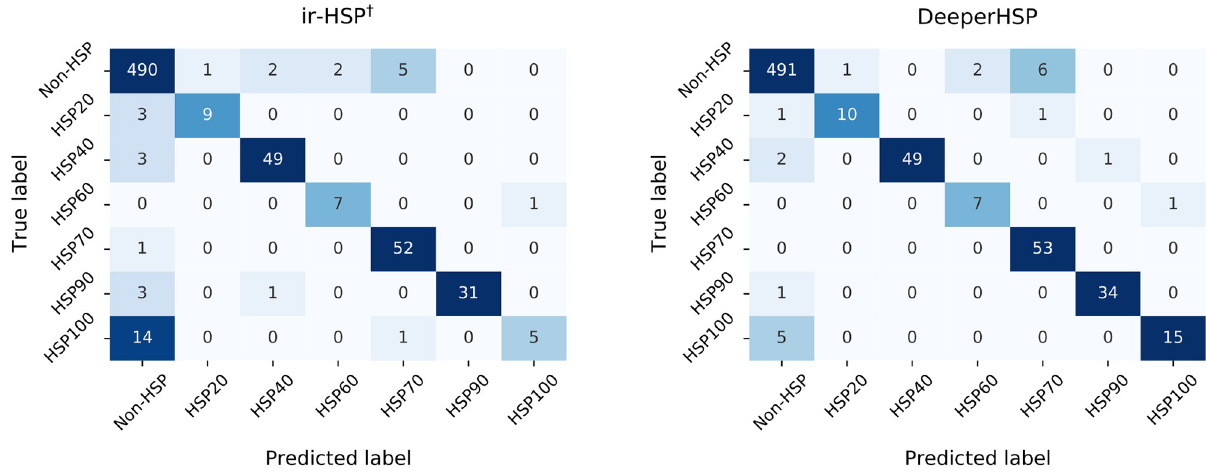
Fig 3. Confusion matrices of the modified ir-HSP and DeeperHSP predictions for the independent test